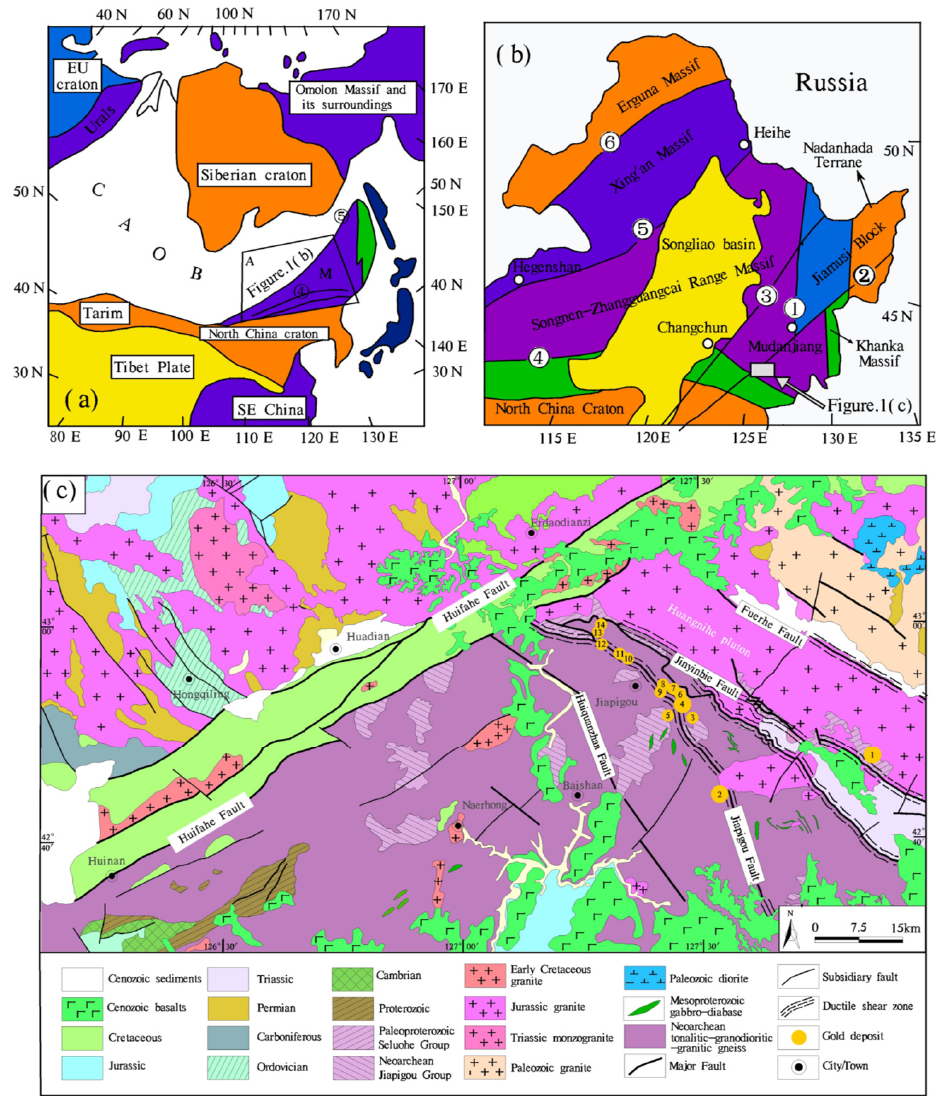
Figure 1. ( a ) Location of NE China with respect to the main tectonic units of China and Russia [9,12,13], ‘A’ and ‘M’ represent the ‘Altaids’ and ‘Manchurides’, respectively. ( b ) Tectonic units of NE China [9,12,13]. ( c ) Regional geological map of the JGMB and distribution of major gold deposits [14,15]. Gold deposits: 1. Songjianghe; 2. Liupiye; 3. Bajiazi; 4. Jiapigou; 5. Erdaogou; 6. Sidaocha; 7. Sandaocha; 8. Xiaobeigou; 9. Daxiangou; 10. Laoniugou; 11. Caiqiangzi; 12. Banmiaozi; 13. Damiaozi; 14. Yuanchaogou. Main faults in ( a , b ): ① Mudanjiang Fault; ② Dunhua–Mishan Fault;